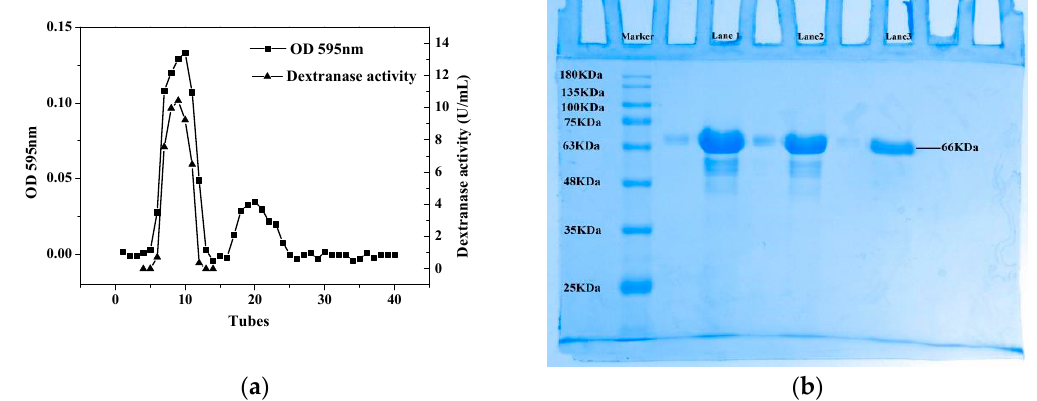
Figure 2. ( a ) Gel filtration chromatography results of the dextranase on Sepharose 6B; ( b ) SDS-PAGE results of the dextranase. For ( b ), lane markers represent marker proteins; Lane 1: the crude enzyme; Lane 2: the ammonium sulphate precipitate; Lane 3: the purified dextranase, collected from gel filtration chromatography.